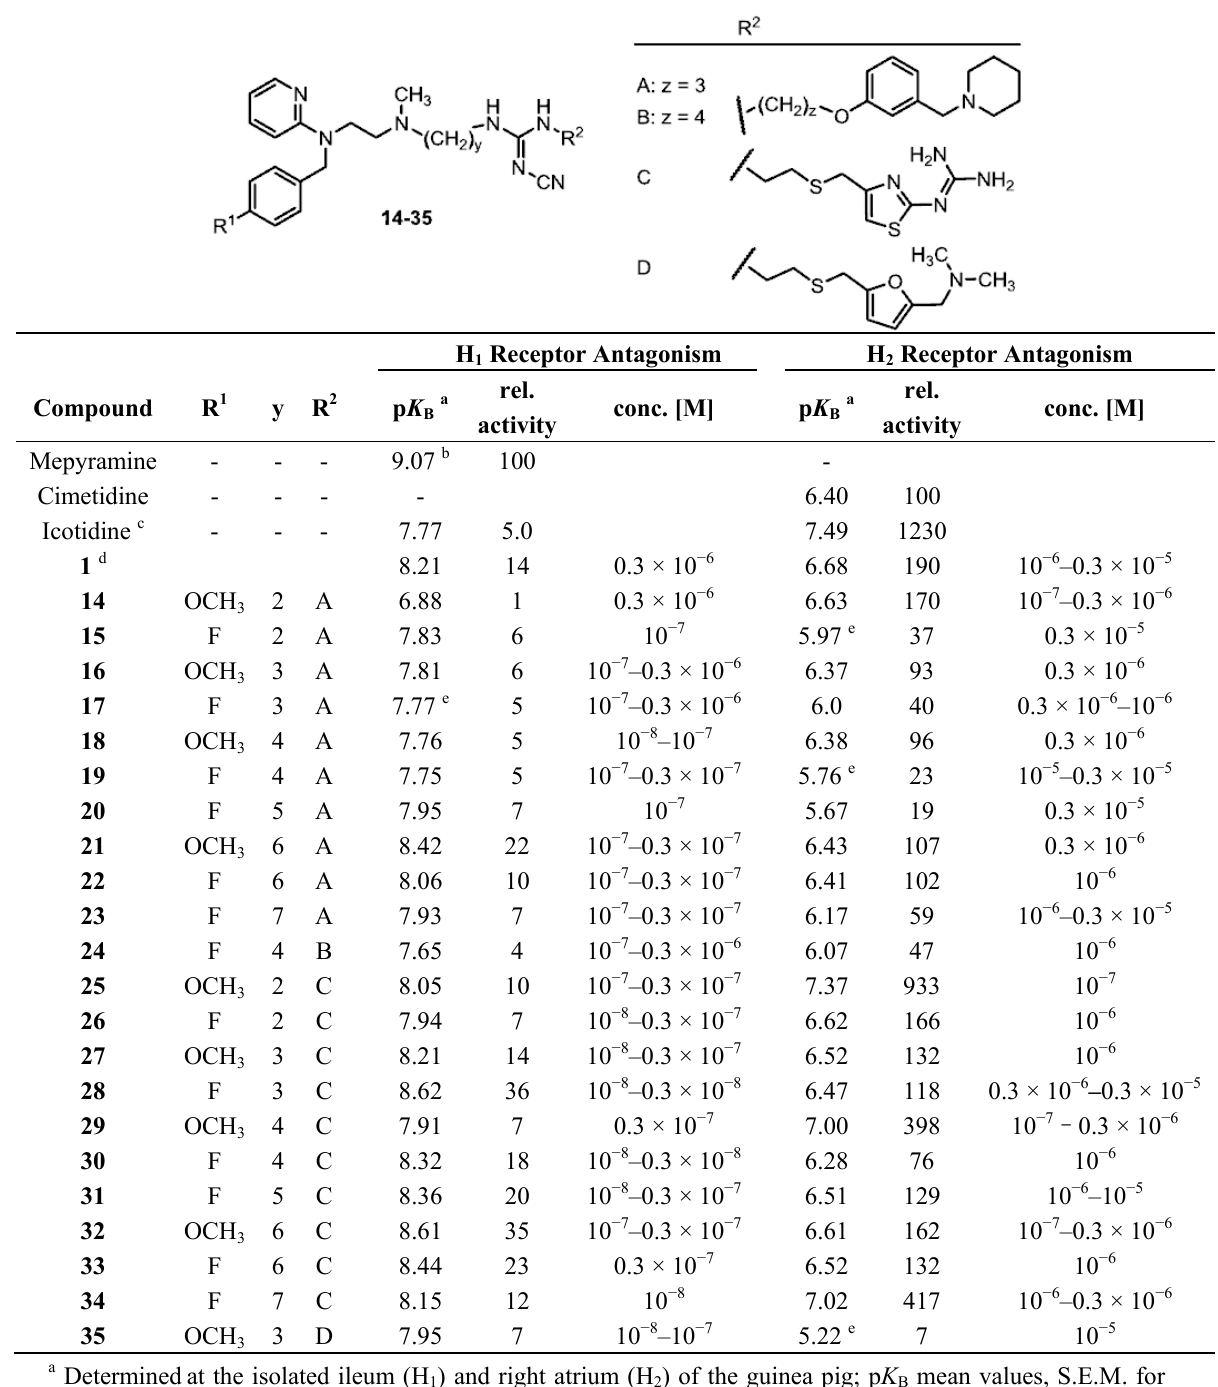
and H receptor antagonism of cyanoguanidines 14 – 35 1 2